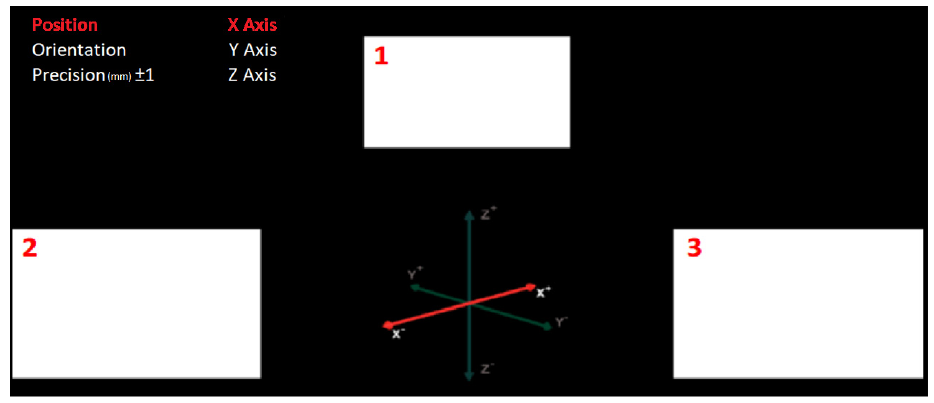
Figure 8. GUI for the control of the robotic arm.